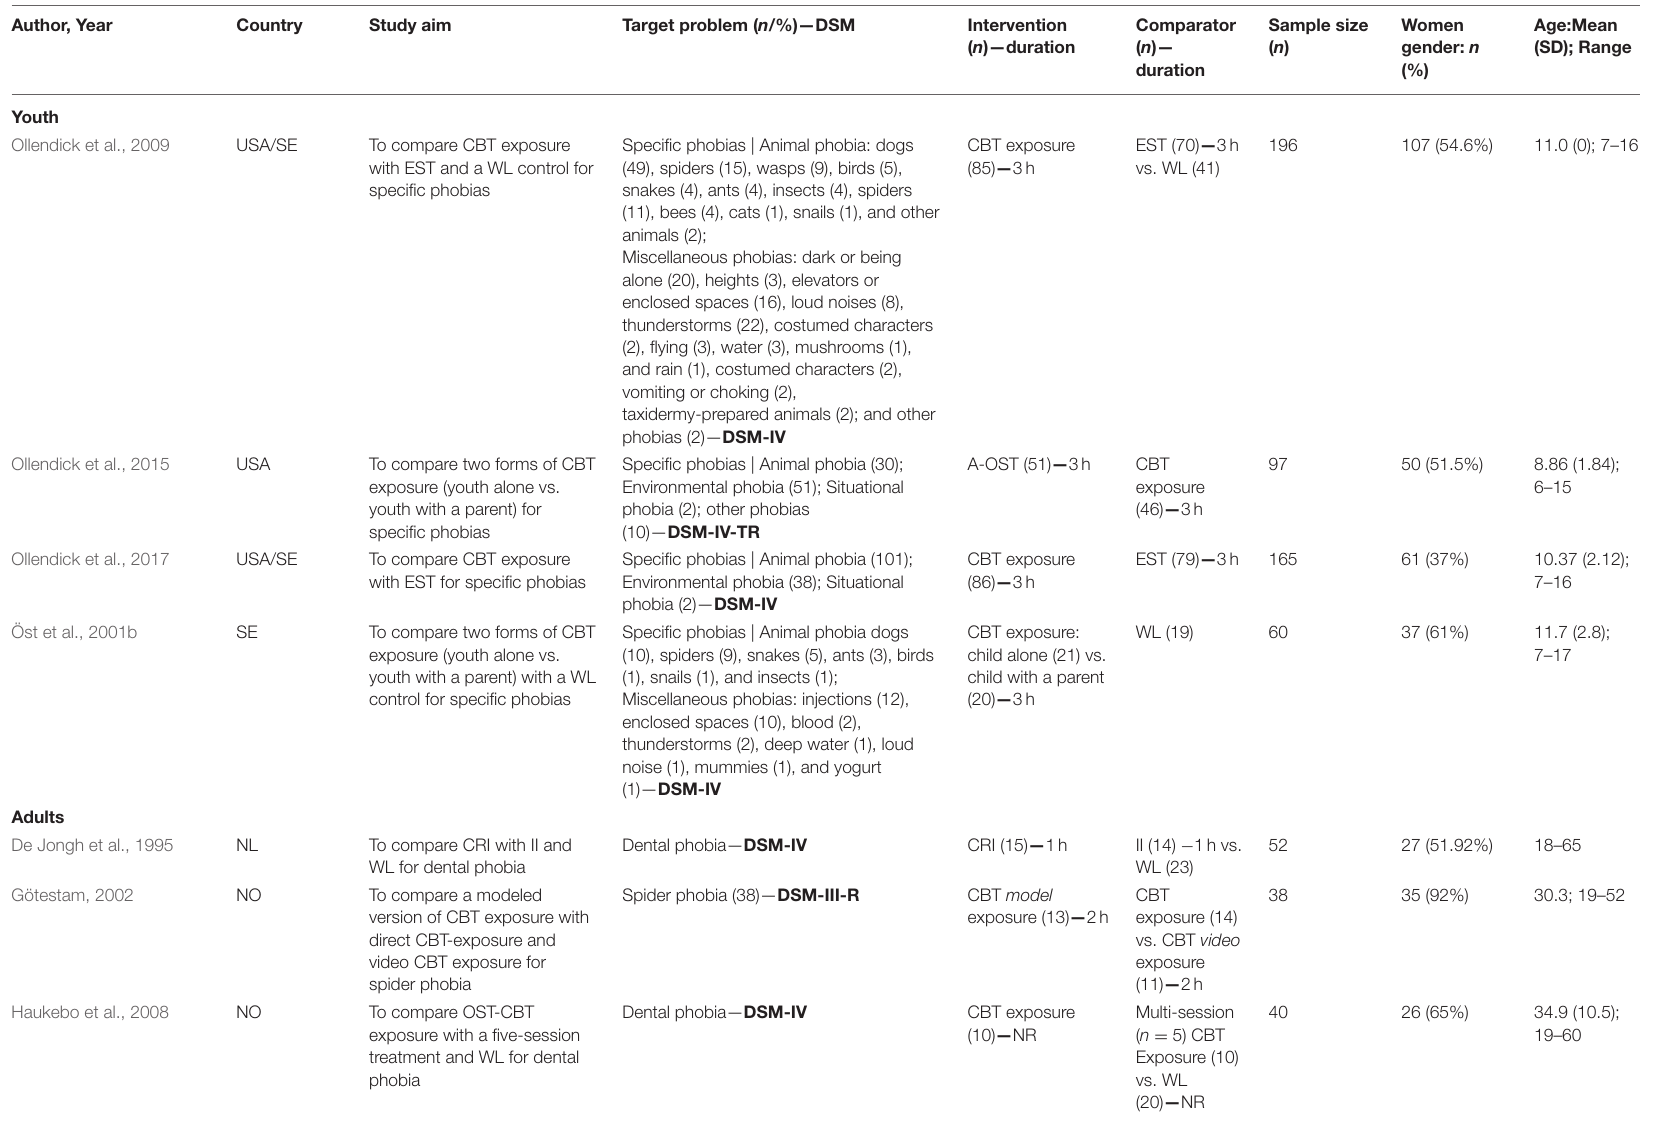
TABLE 1 | Characteristics of the included